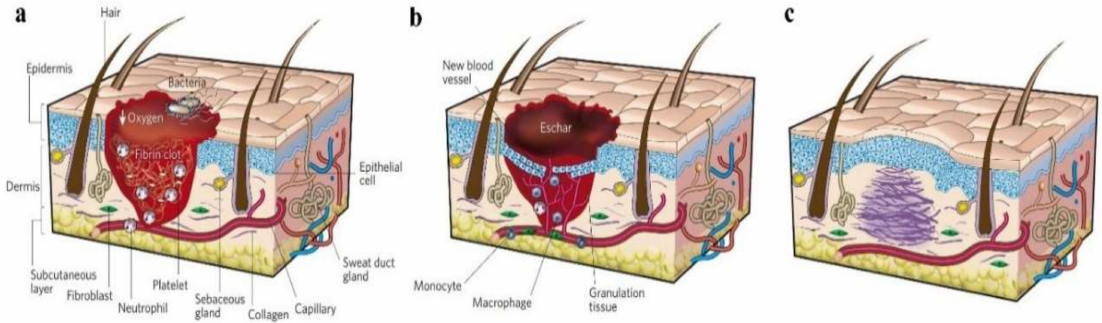
Figure 4. Classic stages of wound repair. There are three classic stages of wound repair: inflammation ( a ), new tissue formation ( b ), and remodeling ( c ) [59]. Reproduced with permission from Springer Nature,